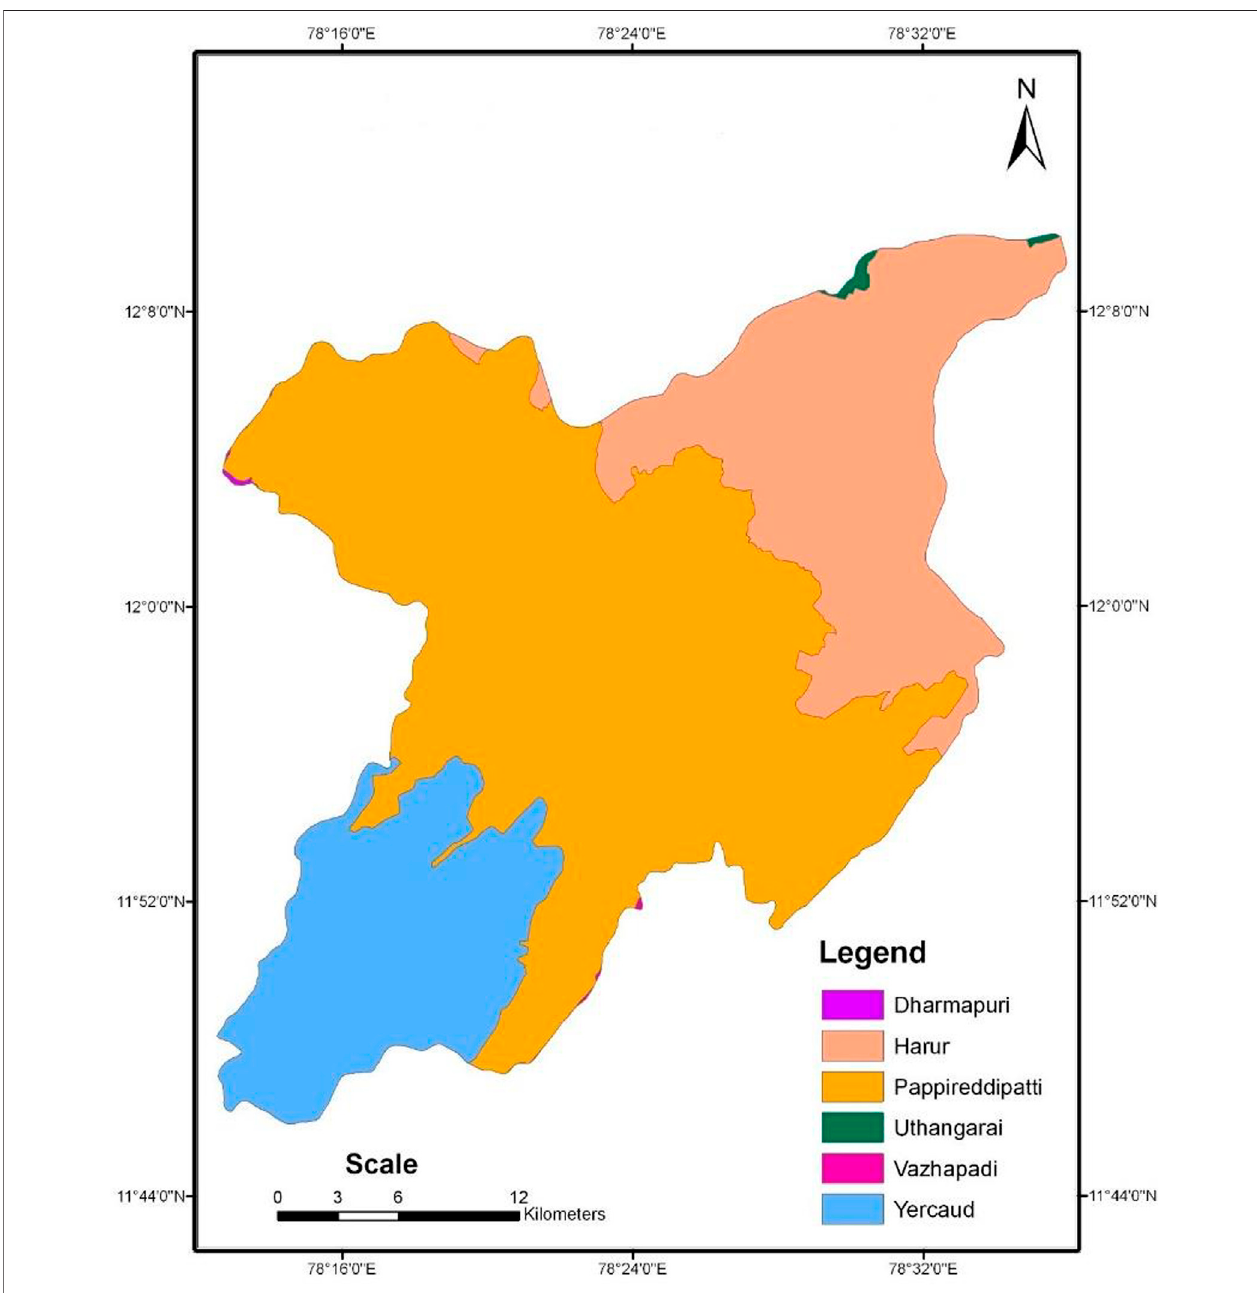
FIGURE 2 | Taluk map of the Vanniyar basin, Dharmapuri district, Tamil Nadu, India.